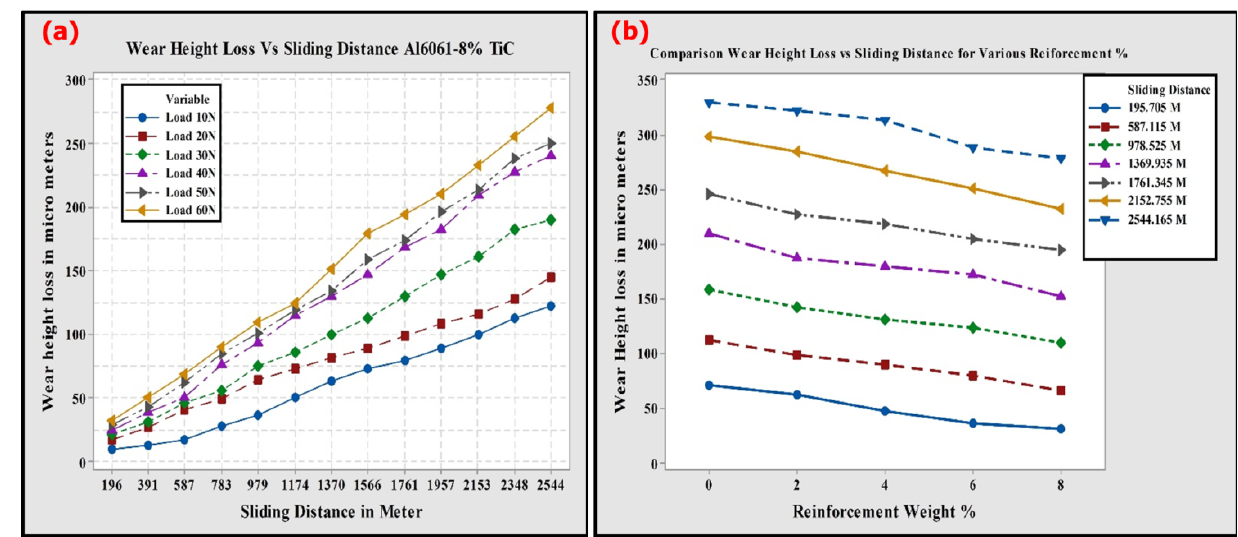
Figure 9. ( a ) the consequence of load on the wear height loss with SD increase on Al6061-8 wt.% of TiC MMCs; ( b ) wear height loss of Al6061 and TiC-filled MMCs with percentage (%) increase of TiC at a load of 60 N.